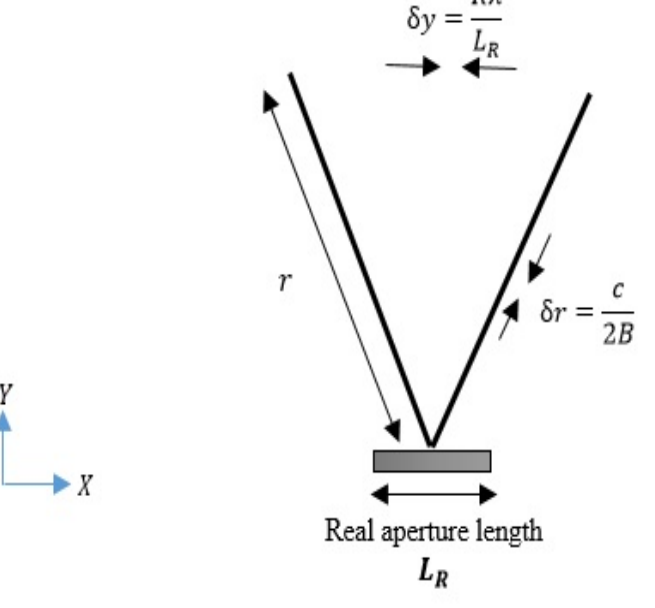
Figure 1. The geometry of a real aperture sonar. Along-track resolution δ y in the range r with wavelength λ proportional to wavelength and inversely proportional to aperture length L R . By increasing frequency and aperture length, the resolution improves. For example, to achieve a 1 m along-track resolution in a 100 m range with 10 kHz frequency, a 15 m aperture is required. δ r, c, and B are across-track resolution, sound speed in the water, and bandwidth, respectively. SAS technology nature is very similar to Synthetic Aperture Radar (SAR); by moving the sonar platform forward and collecting multiple pulse-echoes, a longer aperture is synthetically formed, such that sonar along-track resolution is improved. The SAS system can produce accurate seabed models by detecting echo entry angles from the seabed. Therefore, SAS has a multi-use technology with good potential in various fields such as offshore oil and gas pipeline installation and inspection, imaging, mapping, deep-sea mining, and underwater archeology [26,29,30]. Figure 2 shows the synthetic aperture geometry in the SAS